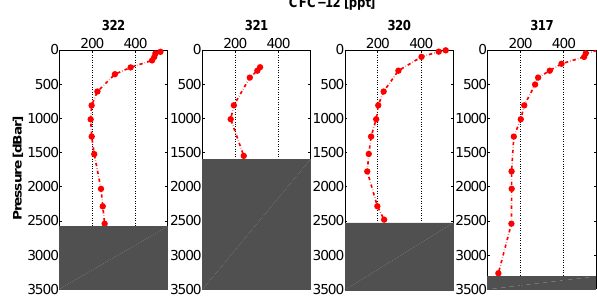
Figure 10. CFC-12 concentration in ppt along the shallow sill be- tween Sardinia and Sicily. The elevated CFC-12 concentration of Fig. 10: CFC-12 concentration in ppt along the shallow sill between Sardinia and Sicily. The elevated CFC-12 concentration the bottom layer indicates the overflow of WMDW into the Tyrrhe- of the bottom layer indicates the overflow of WMDW into the Tyrrhenian Sea. The depth of each station is indicated by the nian Sea. The depth of each station is indicated by the gray patch in grey patch in each panel. each panel.